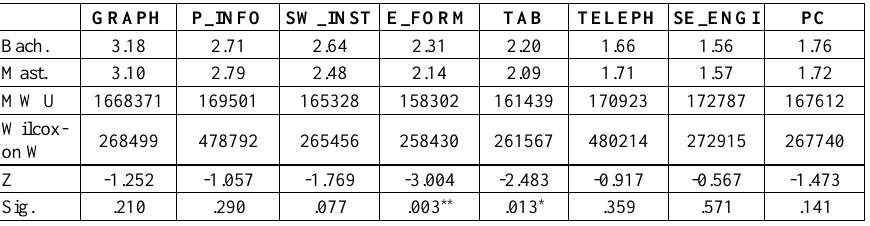
Table 6. Dependence of digital literacy on the study programmes